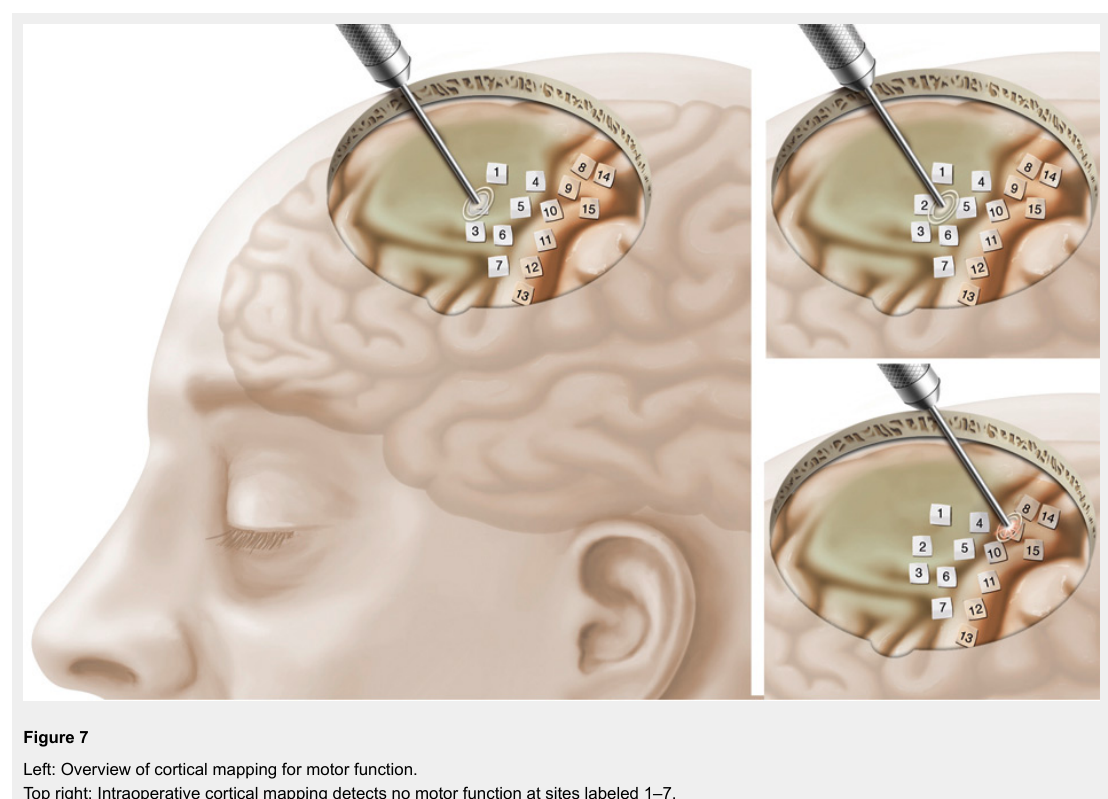
Figure 7 Left: Overview of cortical mapping for motor function. Top right: Intraoperative cortical mapping detects no motor function at sites labeled 1–7. Bottom right: Motor function of the hand is detected and spared during surgery at site labeled 8 (further motor function sites detected and spared at sites